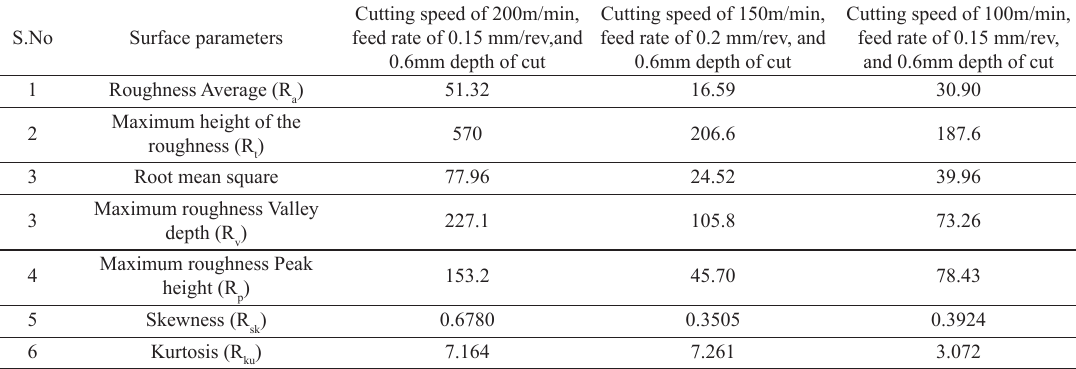
Table 10. Tool surface parameters value at different cutting speed. S.No